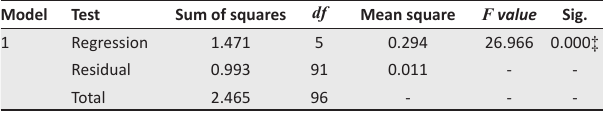
TABLE 6: Analysis of variance of corporate entrepreneurship and service innovation: Analysis of variance.